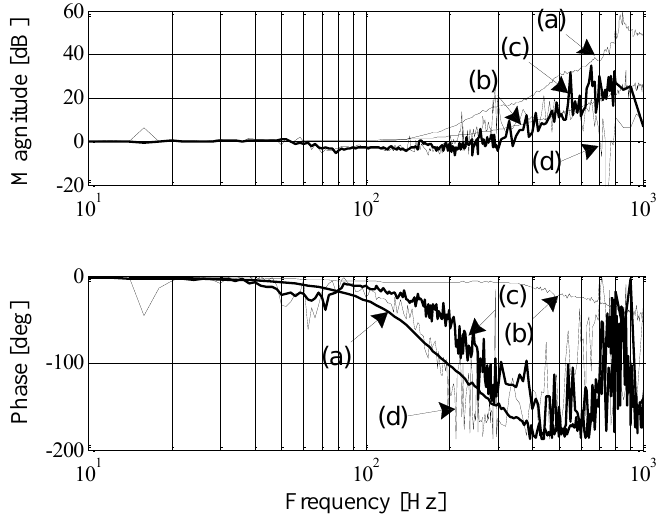
Figure 13. Frequency response of the simulated and experimental position